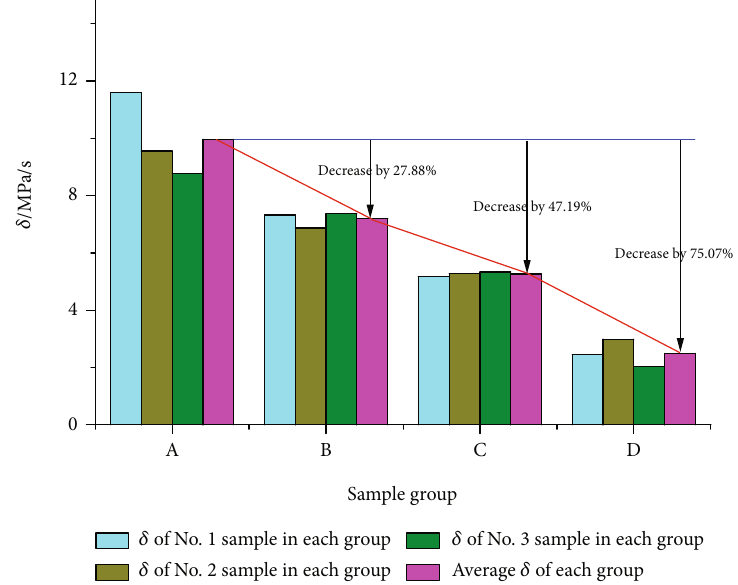
Figure 7: Postpeak stress reduction rates of sandstone samples. Table 2: Mechanical energies applied to sandstone samples. Immersion condition Sample